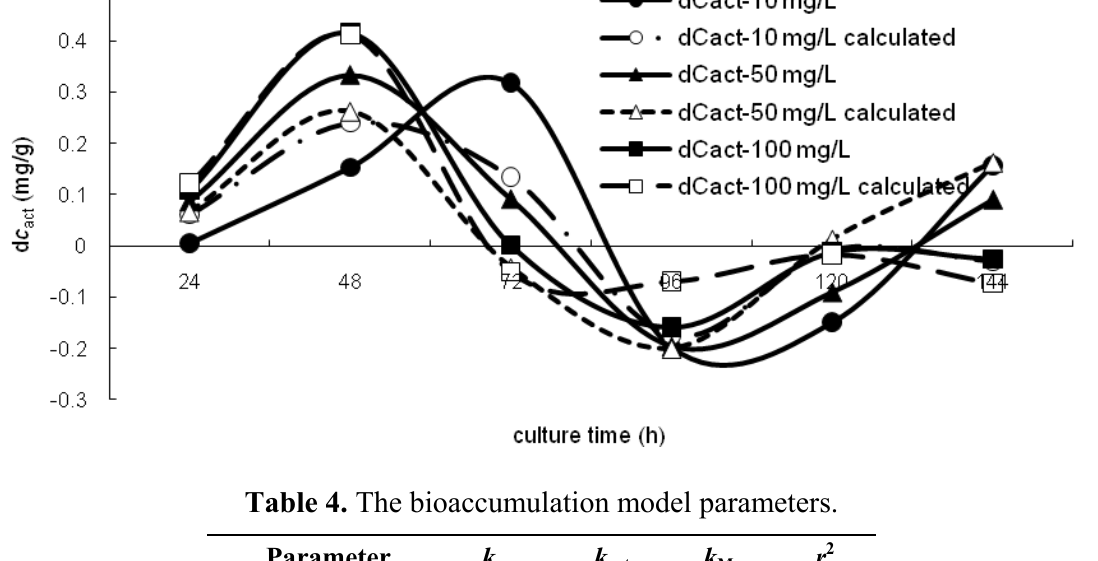
Figure 5. The d c